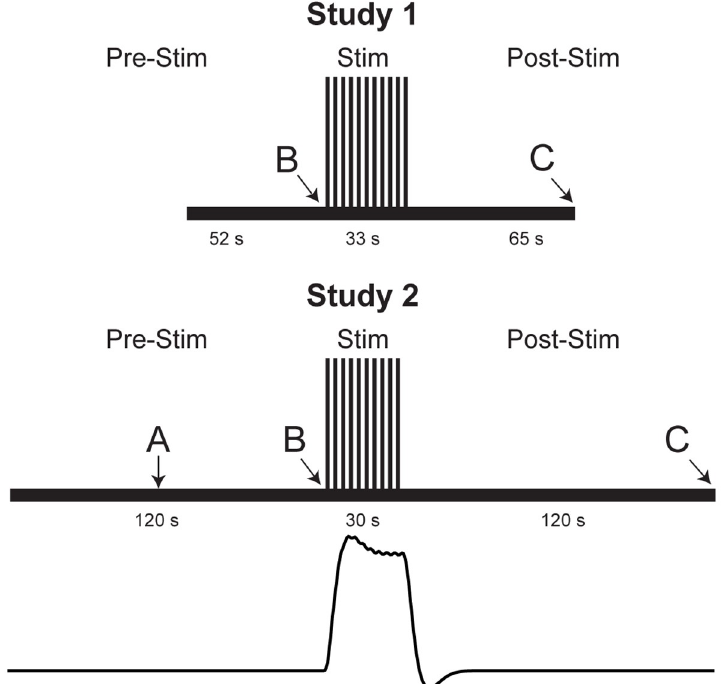
Fig 1. FMRI paradigms for Study 1 and Study 2. Functional imaging runs in Study 1 were 150 seconds long, and the heat pain was administered as 11 consecutive heat spikes over a span of 33 seconds. Functional imaging runs in Study 2 were 270 seconds long, and the heat pain was administered as 10 brief heat contacts over a span of 30 seconds. Letters indicate different prompts being delivered to participants over the rear-projection screen. A = “you will feel heat.” B = “the pain stimulus will begin in 3 ... 2 ... 1 ... ” C = “please provide your first and last pain ratings.” The predicted BOLD response based on the stimulation paradigm is also shown. However, the data sets from each participant consist of between 4 and 6 repeated runs with this stimulation